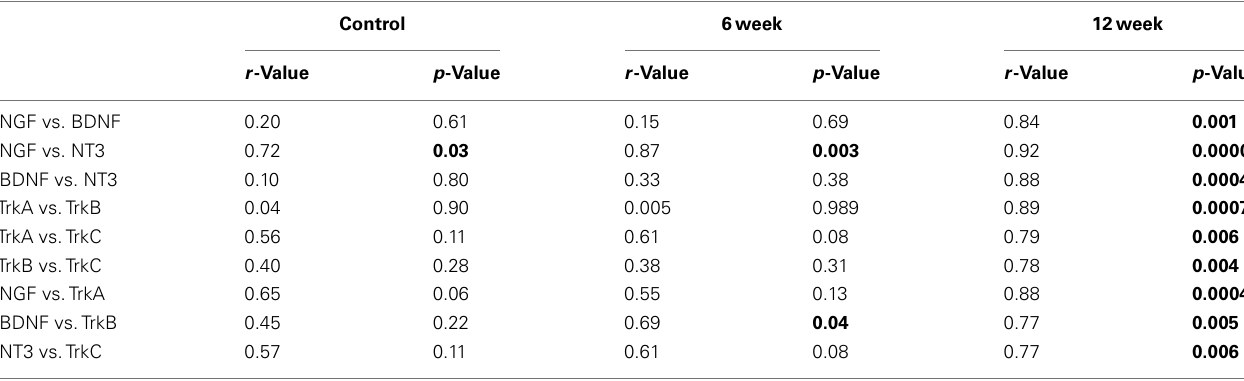
Table 4 | Correlations between expression of mRNA for neurotrophins,Trk receptors, and cognate pairs in DRG.